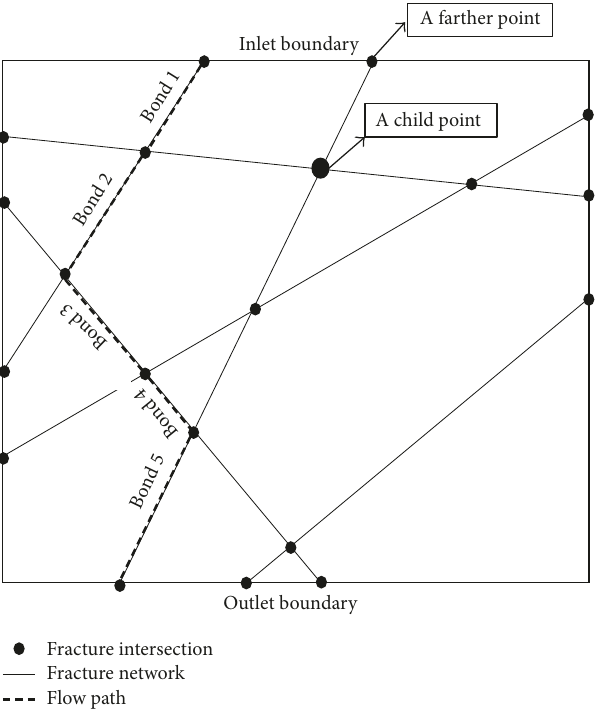
Figure 3: Flow path in fracture network.